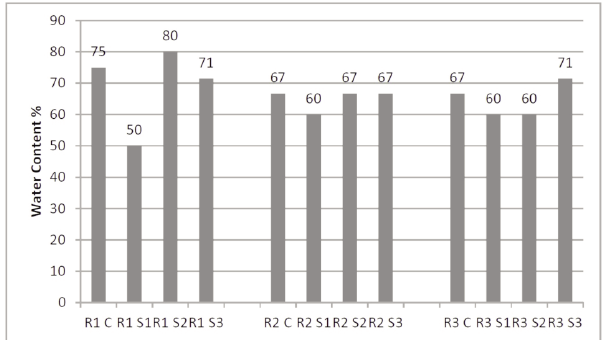
Fig. 3 - The effect of the three rootstocks and salinity levels on ‘Superior Seedless’ leaf water